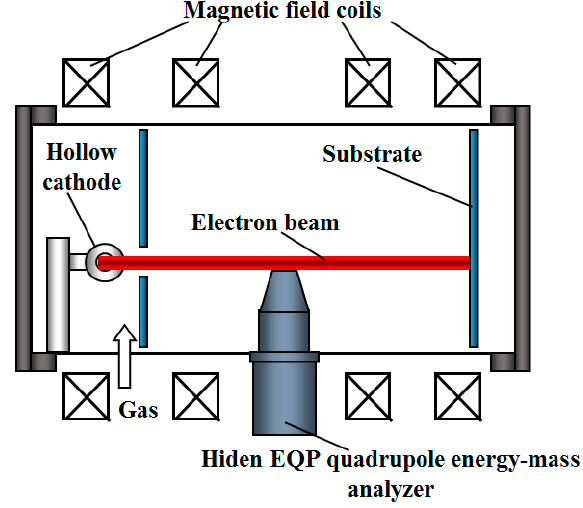
Figure 8. Experimental setup of a LAPPS reactor with an electron beam [76].